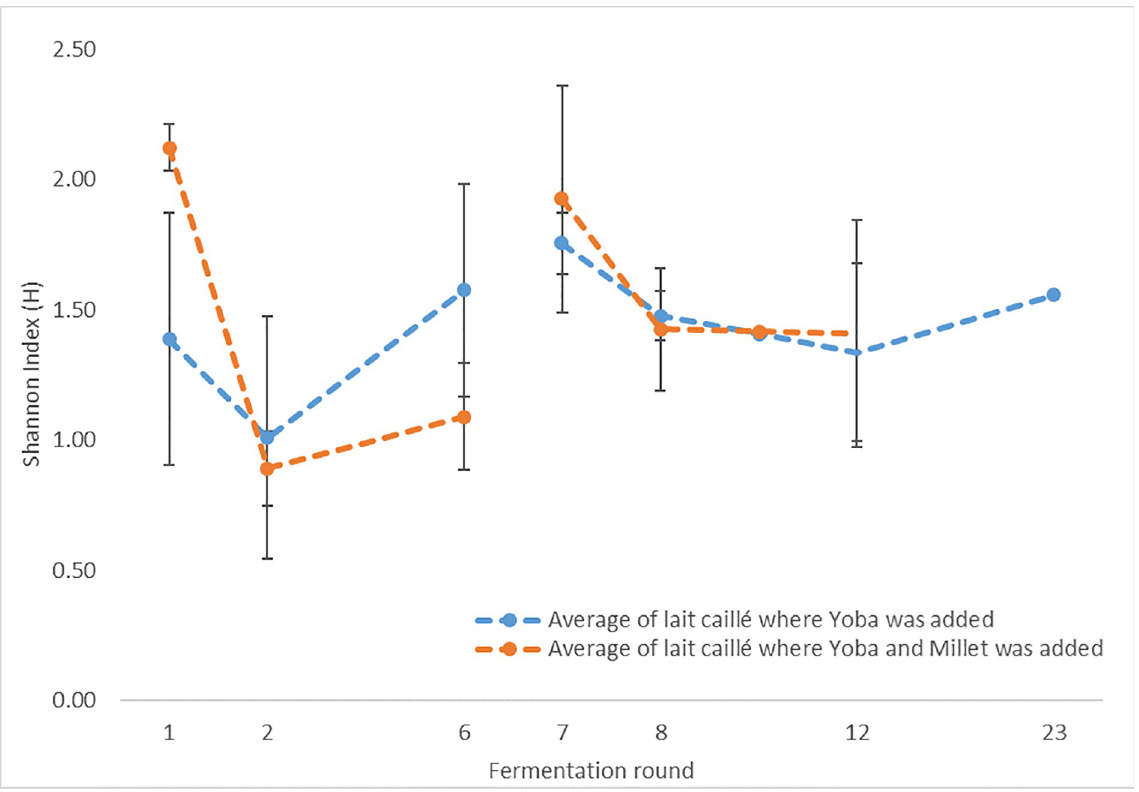
Fig 5. Microbial diversity in lait caille´ during and after the addition of the Yoba starter culture. Average Shannon index of lahals inoculated with Yoba (lahals 3, 6, and 7) and lahals inoculated with Yoba starter culture in combination with millet porridge (lahals 2 and 8). Error bars indicate standard deviation. Yoba starter culture is added to all lahals at fermentation round 1 and 7, millet was added to lahals 2 and 8 at all fermentation rounds (fermentations rounds 3,4,5,9,10,11, and 13 up to 22 were not measured).